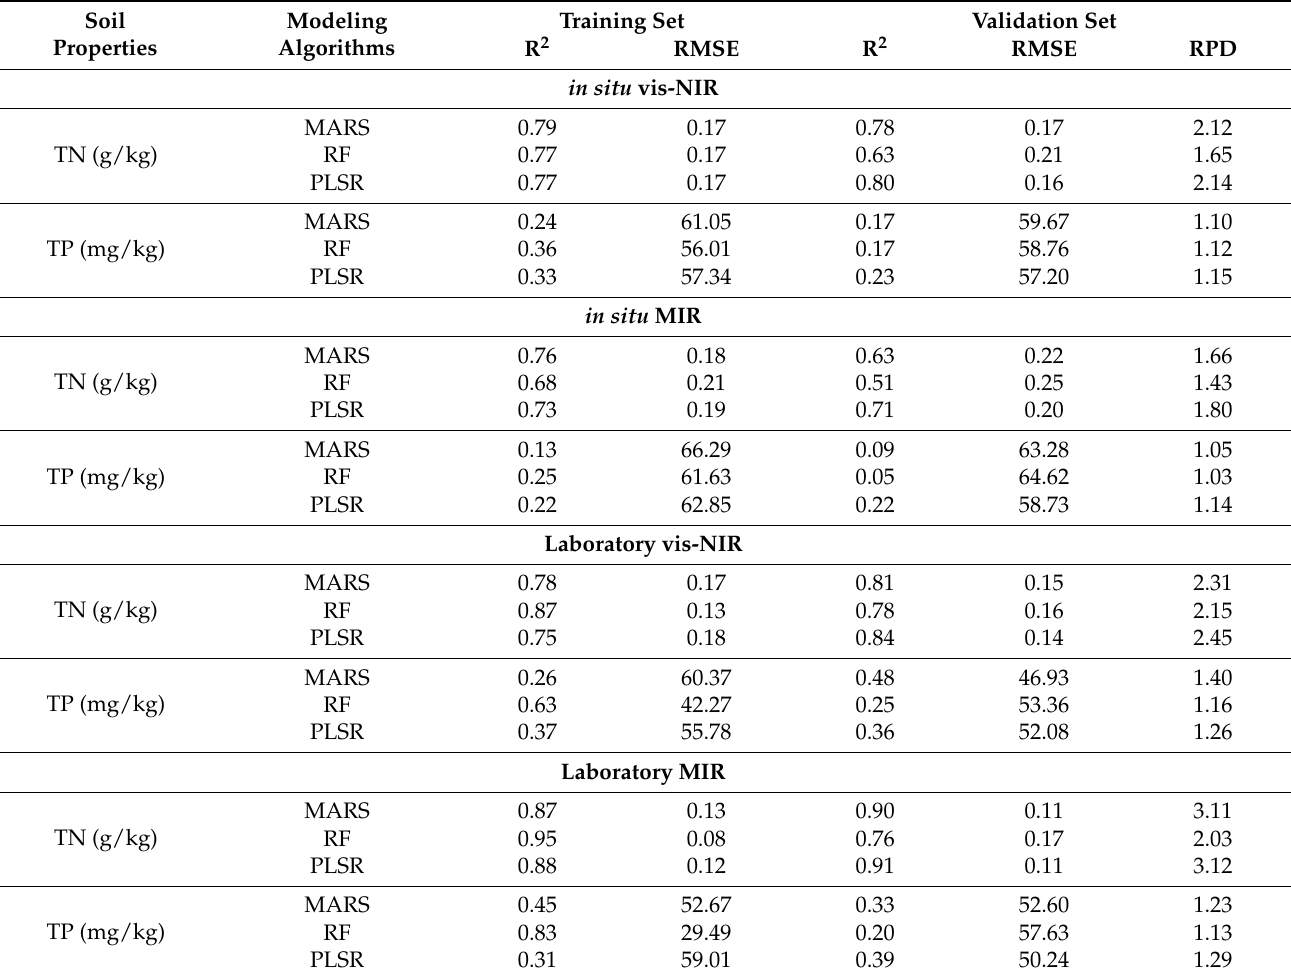
Table 4. Prediction accuracy of soil TN and